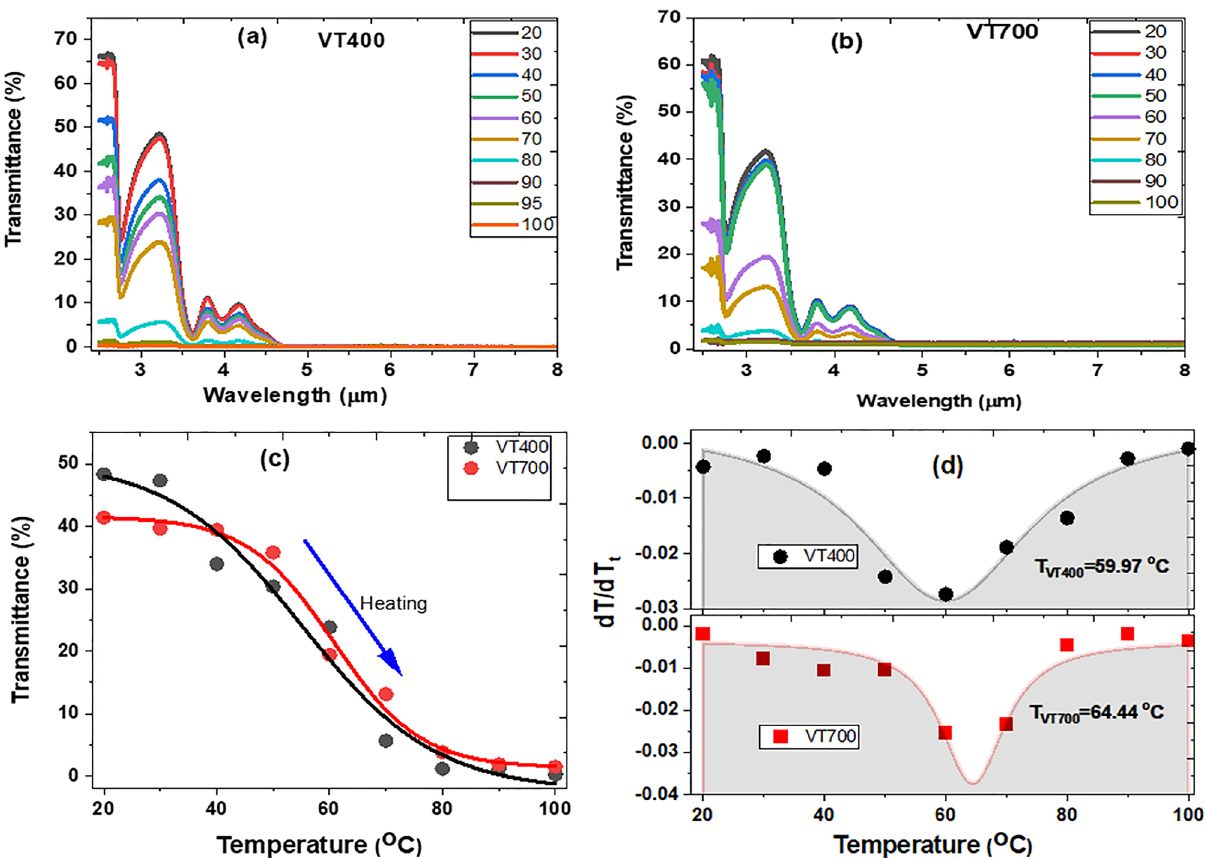
Figure 6. Temperature-dependent transmittance measurements ( a ) VT400 and ( b ) VT700. MIR transmittance as a function of sample temperature for samples VT400 and VT700. ( d ) The differential curves of transmittance to temperature verses heating